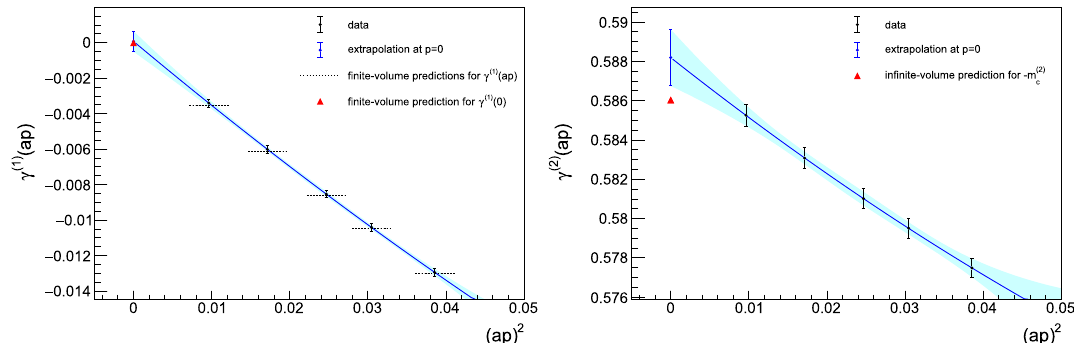
Fig. 1 Measure of γ ( 1 ) ( ap ) (left panel) and γ ( 2 ) ( ap ) (right panel) for a 12 4 lattice with twisted boundary conditions on a plane, N c = 2 and N f = 2 Wilson fermions. The analytic finite-volume critical mass m ( 1 ) c is included in the simulation. A second-order polynomial in ( ap ) 2